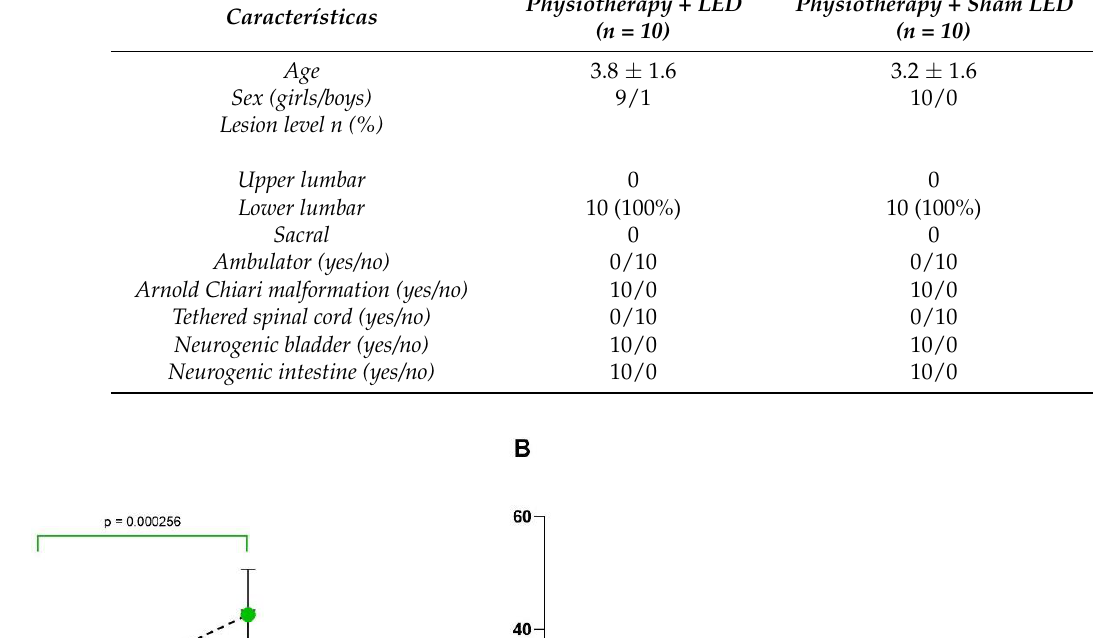
Table 2. Characteristics of participants.